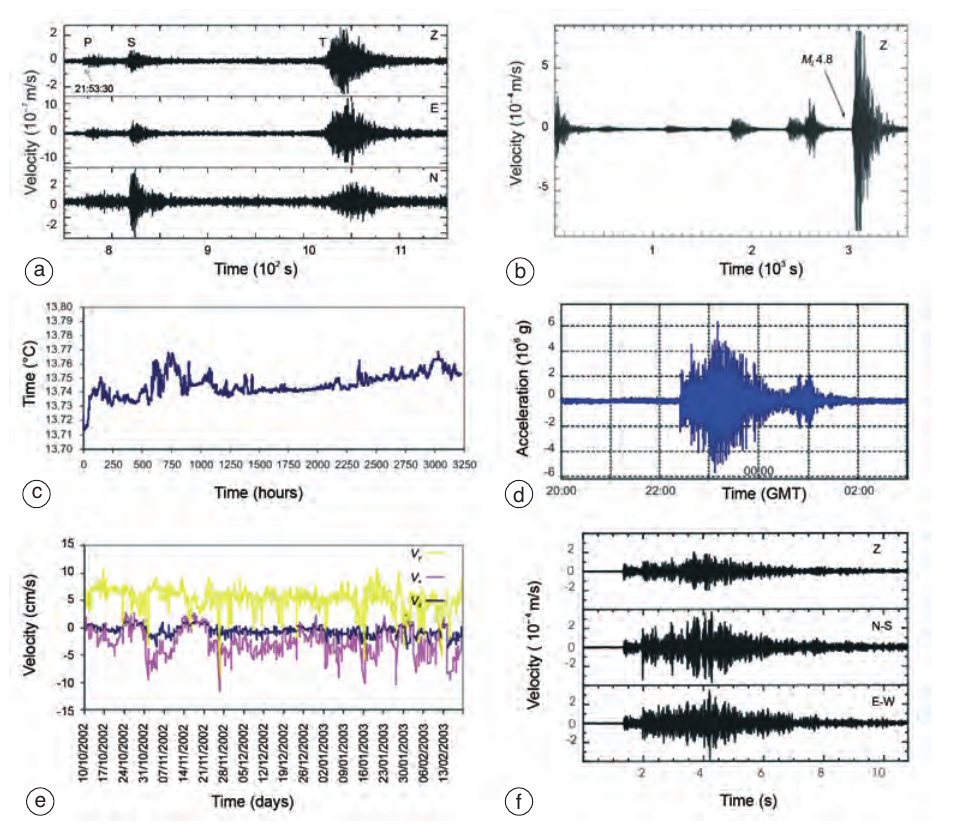
Fig. 11a-f. SN-1 measurements acquired in Ionian Sea at over 2000 m w.d. in stand-alone mode (first mission, 2002-2003) and in real-time acquisition mode (cable connected, since end of January 2005): a) regional earth- quake of 27 December 2002, not reported by land-network bulletins, showing P -, S -, and T -phase arrivals; b) 2002-2003 Mt. Etna eruption, seismic activity of the volcano over one hour (27 October, 2002, 2:00-3:00 a.m.), including the major event of the sequence ( M L = 4.8); c) temperature measured by CTD sensor over the mission period (the mean value is around 13.74°C); d) teleseism occurred in Kuril Islands ( M w = 7.3) and recorded by the gravity meter on 17 November, 2002; e) water current velocity components over the mission period, the N-S component, running along the Sicilian coast from/to the Messina Strait shows the most significant values (in av- erage 5 cm/s); f) real-time acquired waveforms of the 28 March, 2005 Sumatra earthquake ( M w =